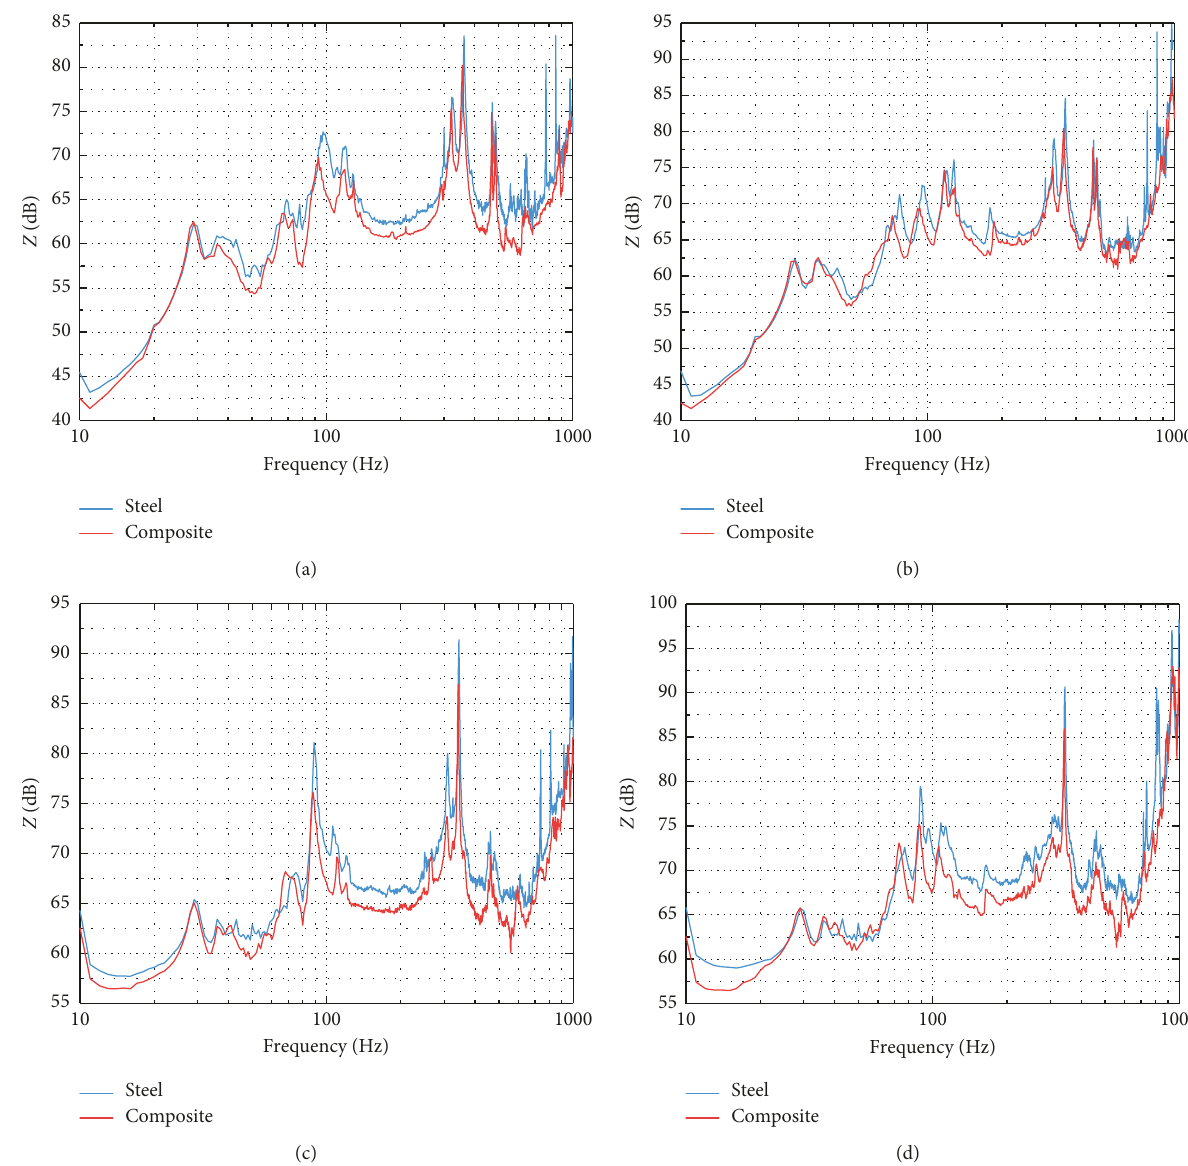
Figure 20: Acceleration admittance curve of steel foundation and composite foundation under different excitation points and temperatures. (a) 20 ° C, excitation point A; (b) 20 ° C, excitation point B; (c) 300 ° C, excitation point A; (d) 300 ° C, excitation point